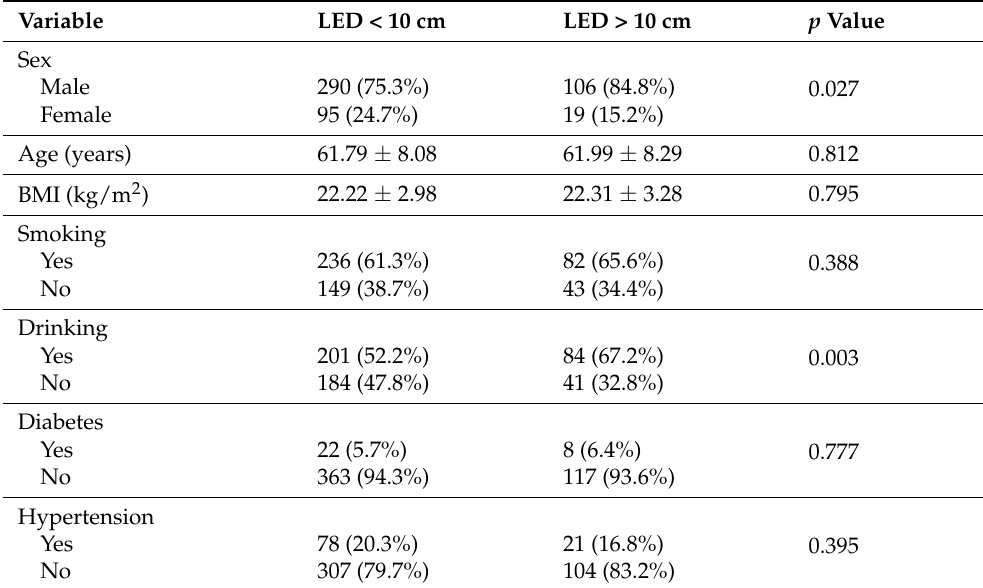
Table 3. Characteristics between groups with short LEDs and long